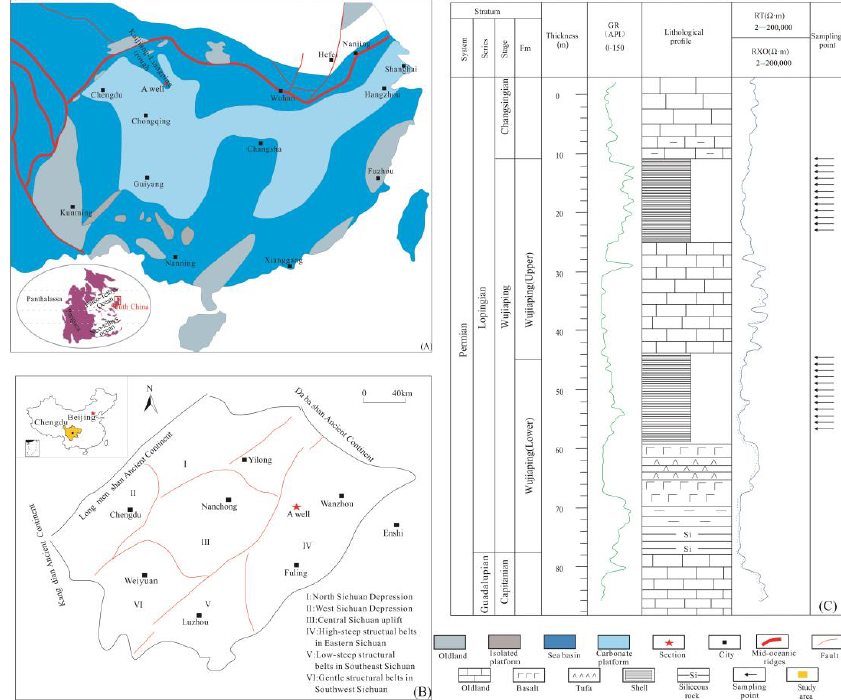
Figure 1. Paleogeographic map ( A ), geographic location ( B ), and stratigraphic column ( C ) of the Kaijiang-Liangping Trough: ( A ) paleogeographic map of Kaijiang-Liangping Trough [1]; ( B ) geographical location map of Kaijiang-Liangping Trough; ( C ) stratigraphic column of Kaijiang-Liangping Trough.